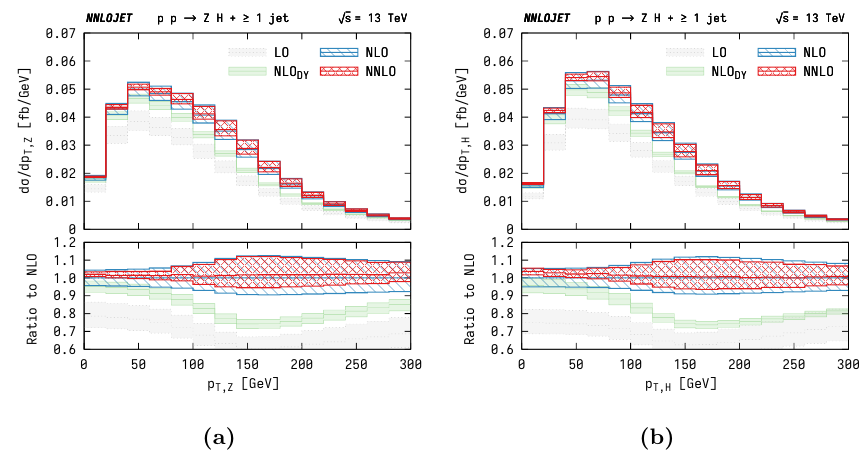
Figure 8. The transverse momentum of (a) the Z-boson and (b) the Higgs boson. figure has a common structure with the top panel showing the absolute distributions at each perturbative order in α while the bottom panel displays the ratio to NLO. The s ingredients (and labelling) of the cross section results at the k -th order in α are in-line s with the expressions presented in section 2.3. In particular, it is worth recalling that the gluon-gluon fusion contribution is included here in both the NLO and NNLO cross section expressions, as defined in eq.